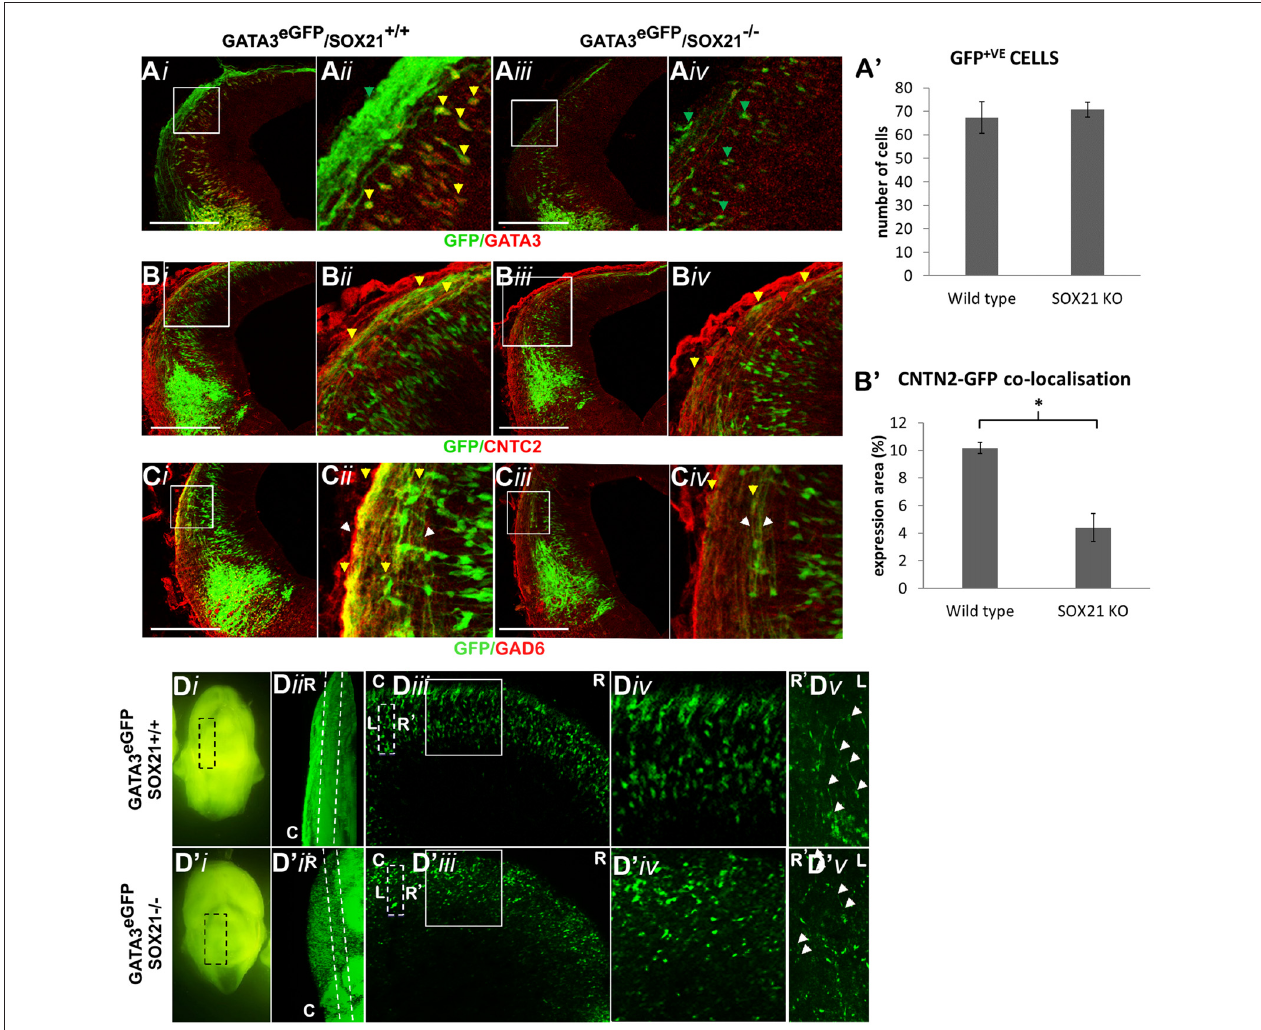
FIGURE 6 | Analysis of the GABAergic neuron maturation in GATA3 eGFP /SOX21 − / − E12.5 embryos. The immunostaining of the GABAergic marker GATA3 was shown to be reduced in the knockout embryos ( iii,iv ) in comparison to the wild type ( i,ii ) despite no noticeable changes in the expression of GFP (A,A (cid:48) ) . Immunostaining of the sections with CNTN2 illustrated a significant reduction in the co-localization with the GFP + ve axons in the absence of SOX21 (B,B (cid:48) ) as well as a decrease in the thickness of GAD6 + ve axons (C) —white arrows denote the thickness of the axonal bundle, yellow arrows denote GAD6 co-localization. In addition, the arrangement of the GFP + ve cells was investigated in E12.5 clarified midbrains (D) . The dashed lines of the panel ( D iii , D (cid:48) iii ) denote the magnified region shown in panel ( D v , D (cid:48) v ) and the white arrows indicate the axonal length (R-Rostral, C-Caudal, L-Left, R-Right). Data are represented as mean ± SEM. ∗ n = 10 (5 pairs of mice), P = 0.012, two-tailed Mann-Whitney test. Scale bar, 150 µ